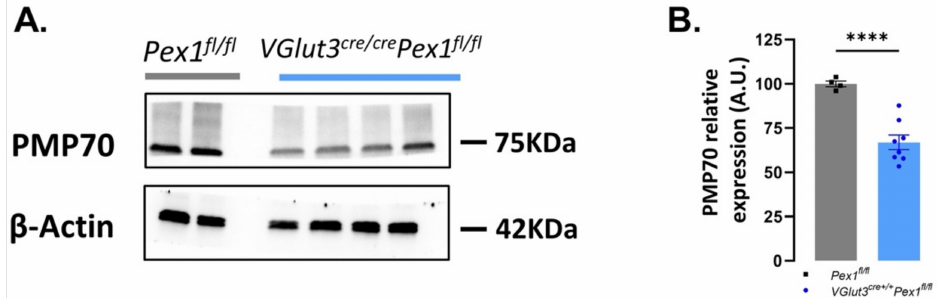
Figure 7. Decrease of relative expression of PMP70 in VGlut3 cre/cre Pex1 fl/fl mice. ( A ) Western blot performed on Pex1 fl/fl and VGlut3 cre/cre Pex1 fl/fl mice at 1.5 months of age on liver tissue; ( B ) Quantifica- tion of the relative expression of PMP70 protein (Table S15—Mean ± S.E.M. **** p < 0.0001,